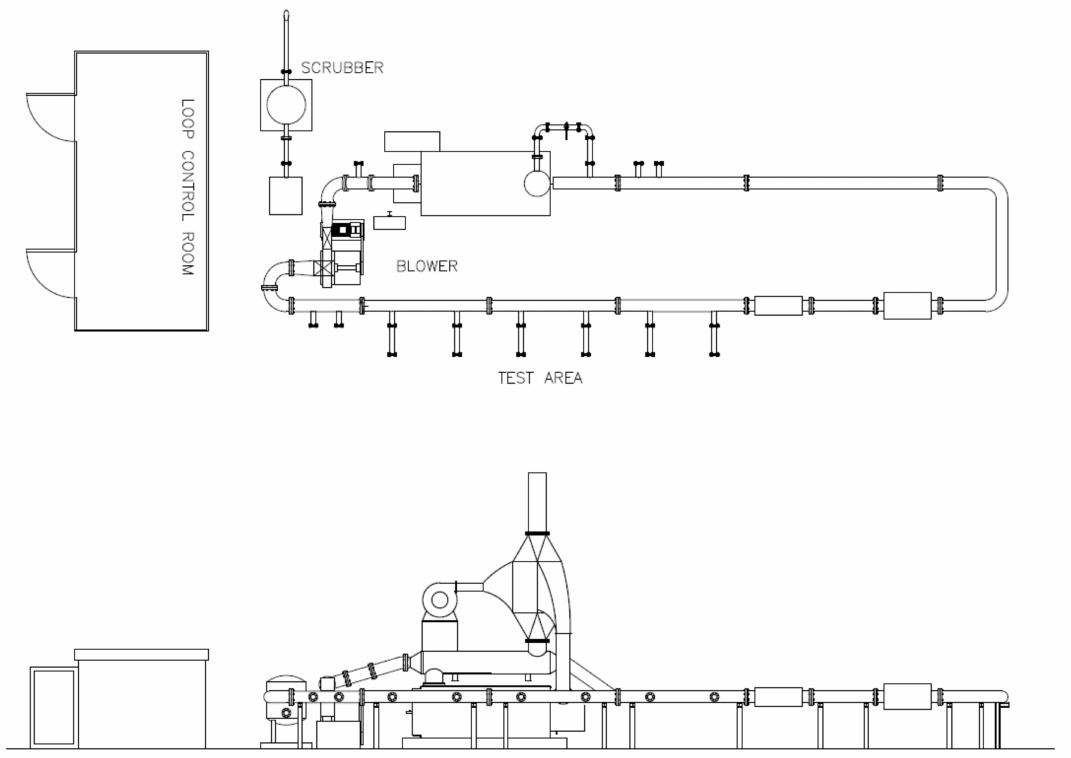
Figure 1. Mechanical dimensions of the LOOP